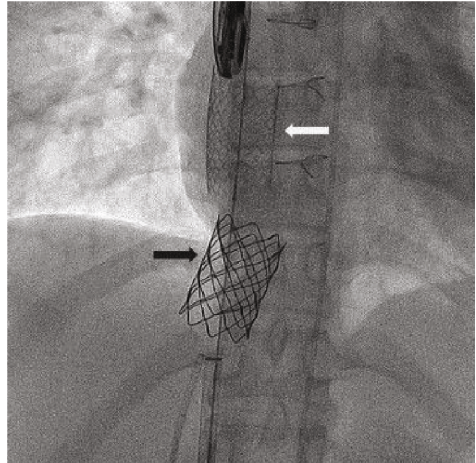
Figure 12: The covered stent unexpectedly embolized into the right atrium as visualized on anterior view angiography of the right atrium. The black arrow and white arrow indicate the position of the bare stent and the covered stent, respectively.